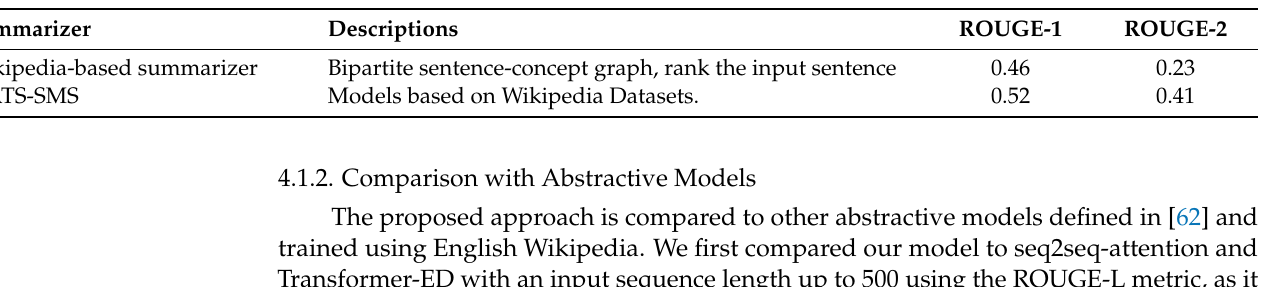
Table 3. Comparison with extractive summarizer.